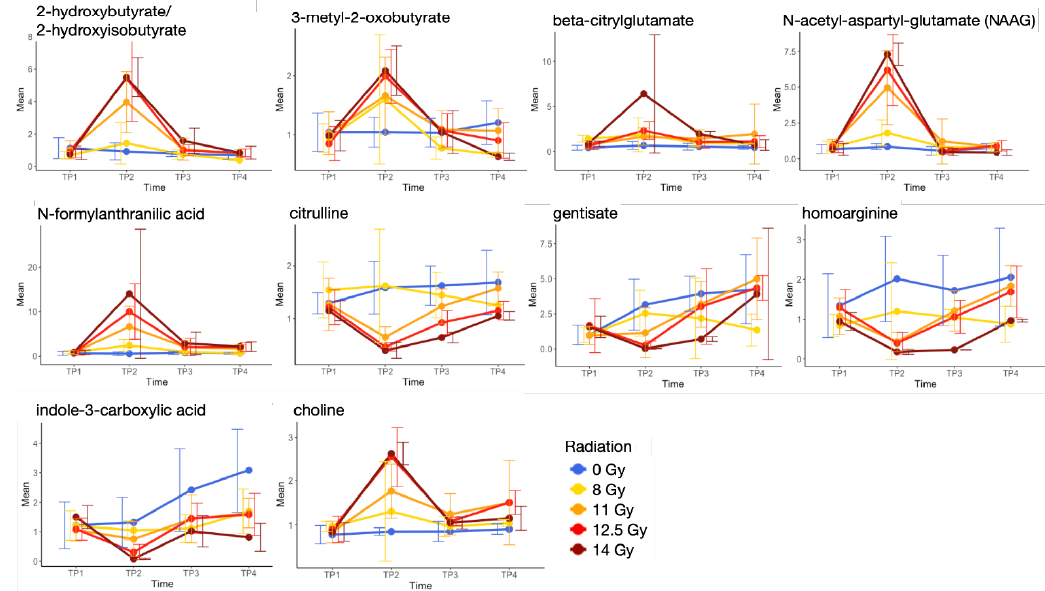
Figure 4. Metabolites in amino acid and lipid superpathways, which show changes according to the radiation dose level at TP2.